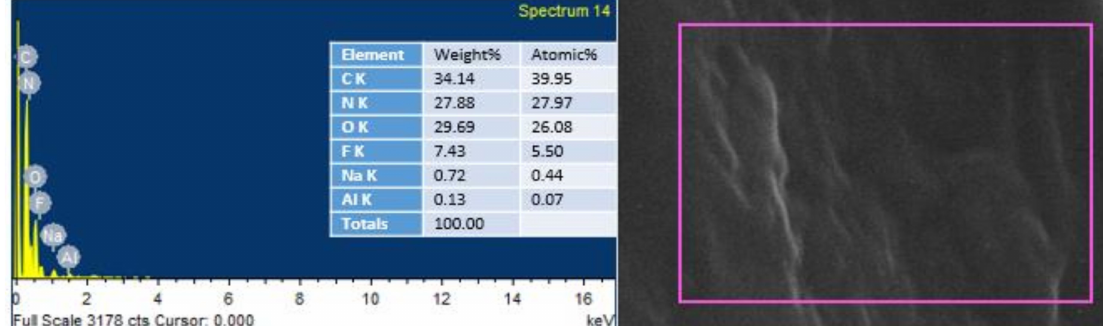
Figure 7. EDS analysis of pure urea–formaldehyde resin.